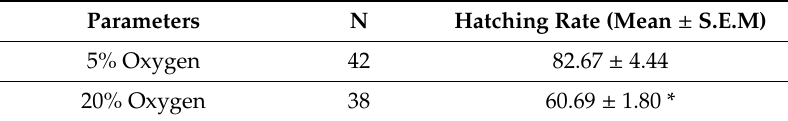
Table 2. Post-warming hatching rate of the blastocysts produced under different levels of oxygen (5% and 20%).